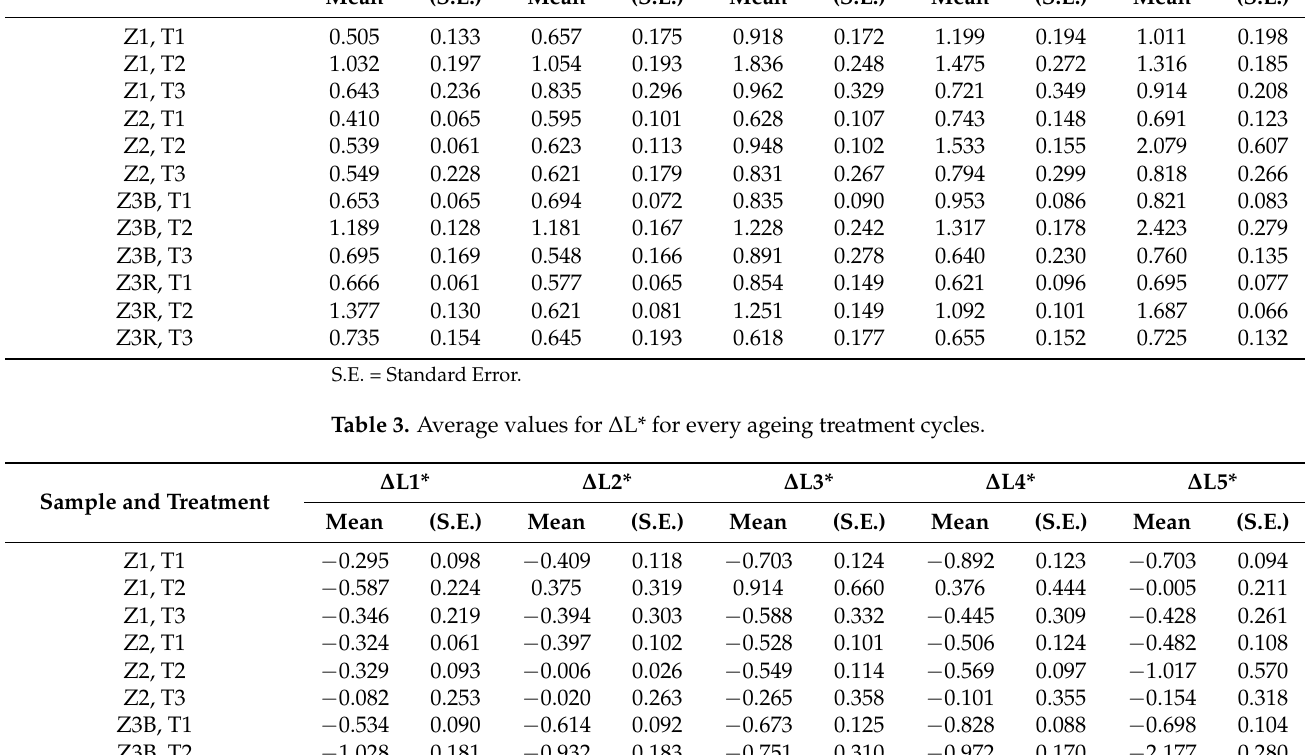
Table 2. Average values for ∆ E* for every ageing treatment cycles. Sample and Treatment